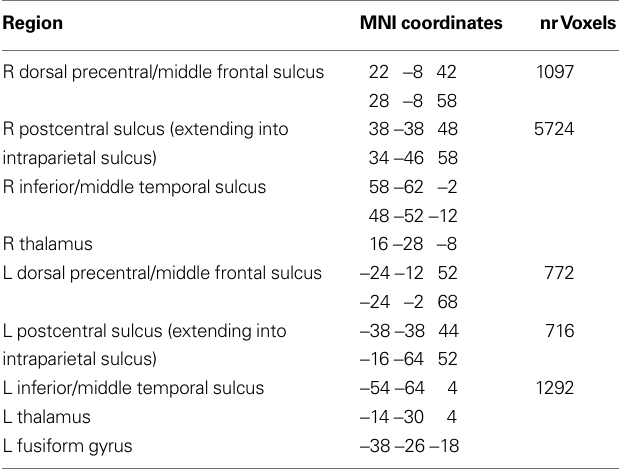
Table 2 | Results of overall MAN > NONMAN comparison (including both groups). Displayed are an anatomical description of activated areas, the coordinates of local maxima within a region in MNI space and the number of voxels per area (2 mm × 2 mm × 2 mm voxels). Results are corrected for multiple comparisons by thresholding at p < 0.005 and taking cluster extent into account to arrive at a p < 0.05 corrected p -value.